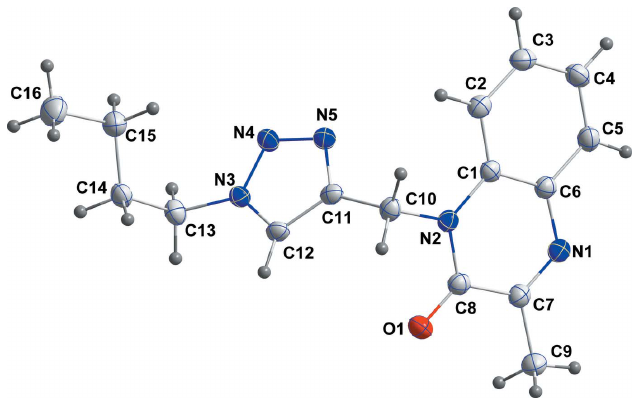
Figure 1 The title molecule with labelling scheme and 50% probability ellipsoids.